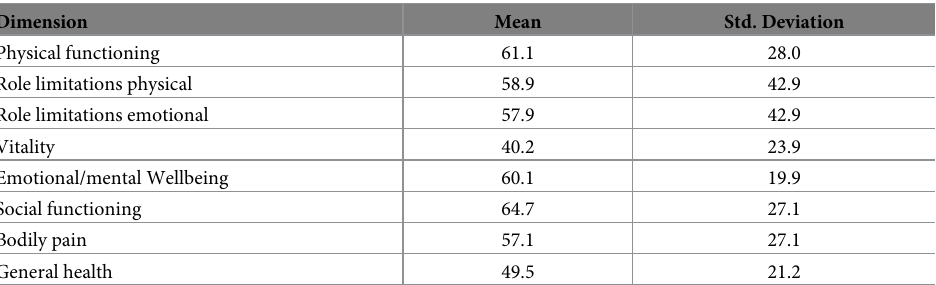
Table 3. Outcome of evaluation of health status in 135 lipoedema cases who completed the SF-36 quality of life questionnaire. Dimension Mean Std.